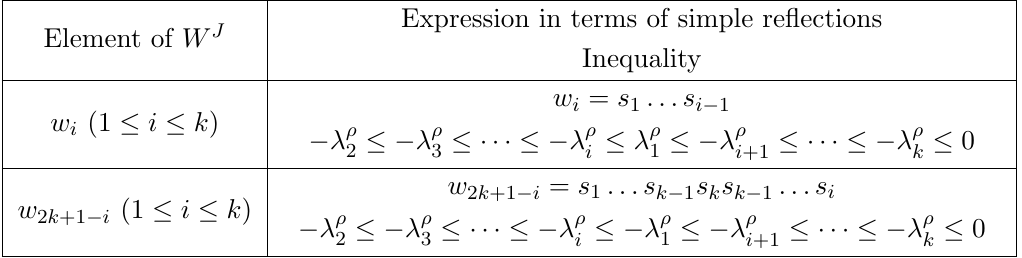
(cid:20) (cid:1) (cid:1) (cid:1) (cid:20) (cid:21) (cid:26) (cid:20) 0. 1 k , for which h (cid:21); (cid:11) _ i = 2 (cid:21) , i i (cid:6) (cid:21) . For a unitary i j ) k (cid:0) 1 . Therefore the ( k (cid:0) 1) 2 roots e (cid:6) e i j 2